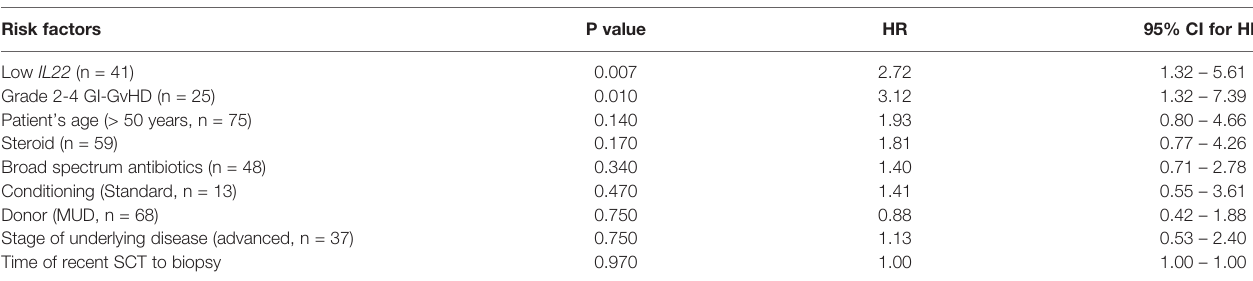
TABLE 3 | Multivariable Cox regression analysis for TRM.